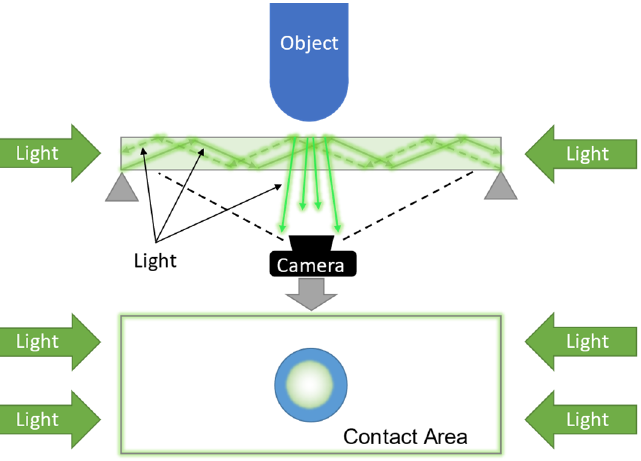
Figure 2. Overview of the contact area deviation method based on the use of a light-conductive plate.